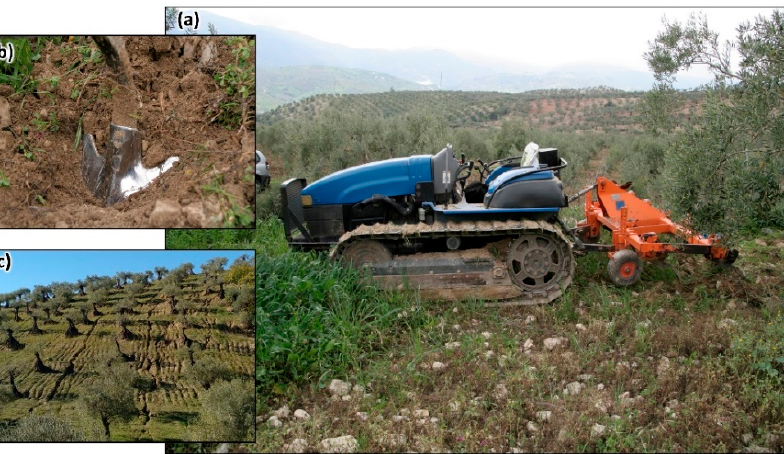
Figure 1. Mechanized tillage tools: crawler tractor equipped with a 2-row, 9-arm cultichisel implement ( a ) with duckfoot grids ( b ); overview of the study site “Pachocho” showing an inadequate tillage pattern (no contour) ( c ).